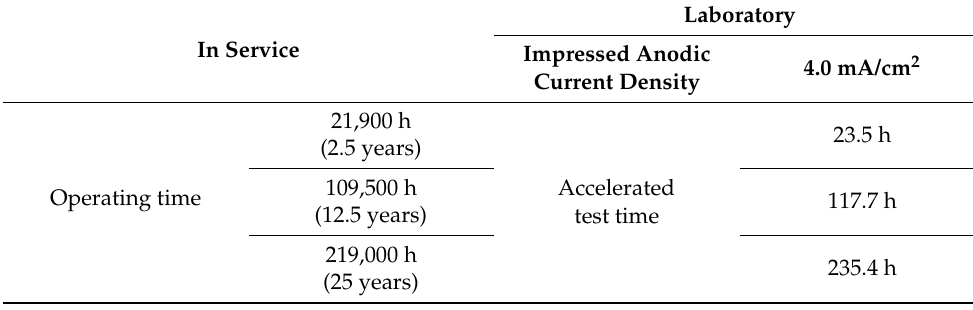
Table 4. Computed testing conditions for the corrosion acceleration test.